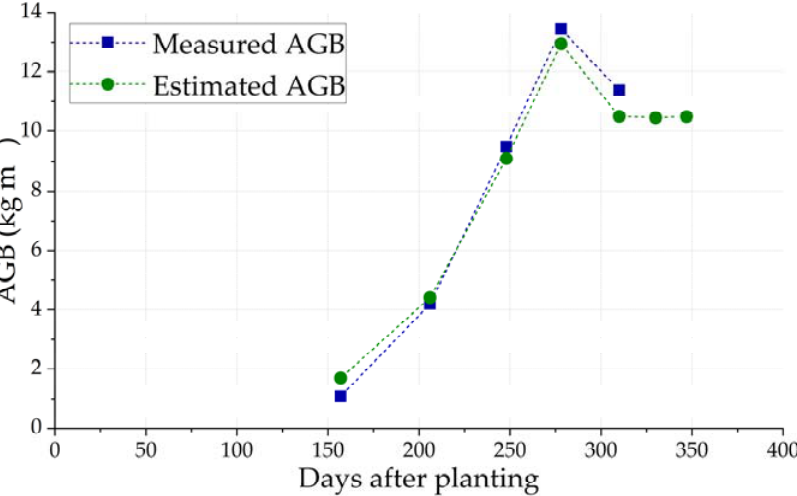
Figure 14. Measured AGB data and estimated AGB data by the band-weighted AGB model along time.